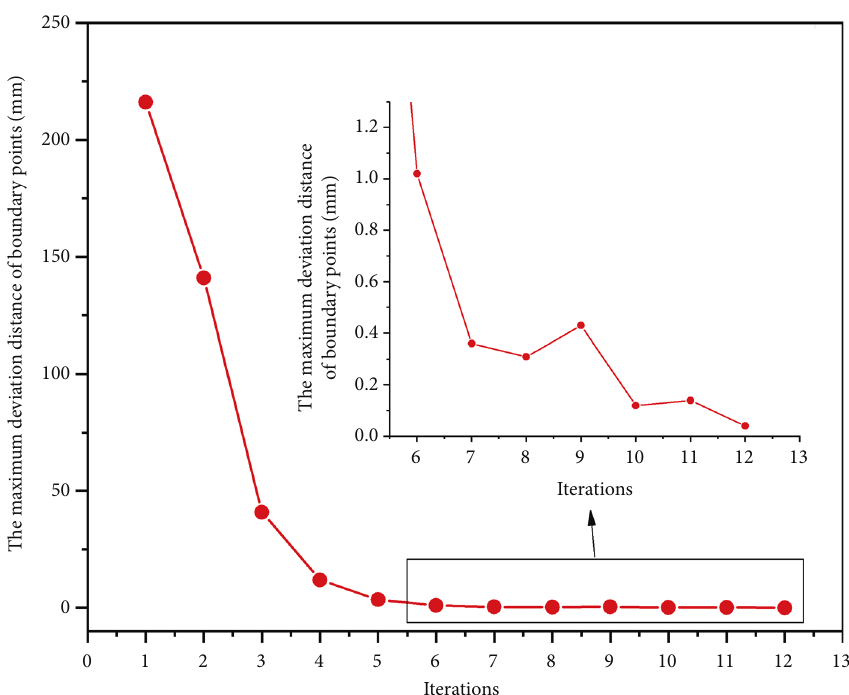
Figure 8: The change of the maximum deviation distance of boundary points with